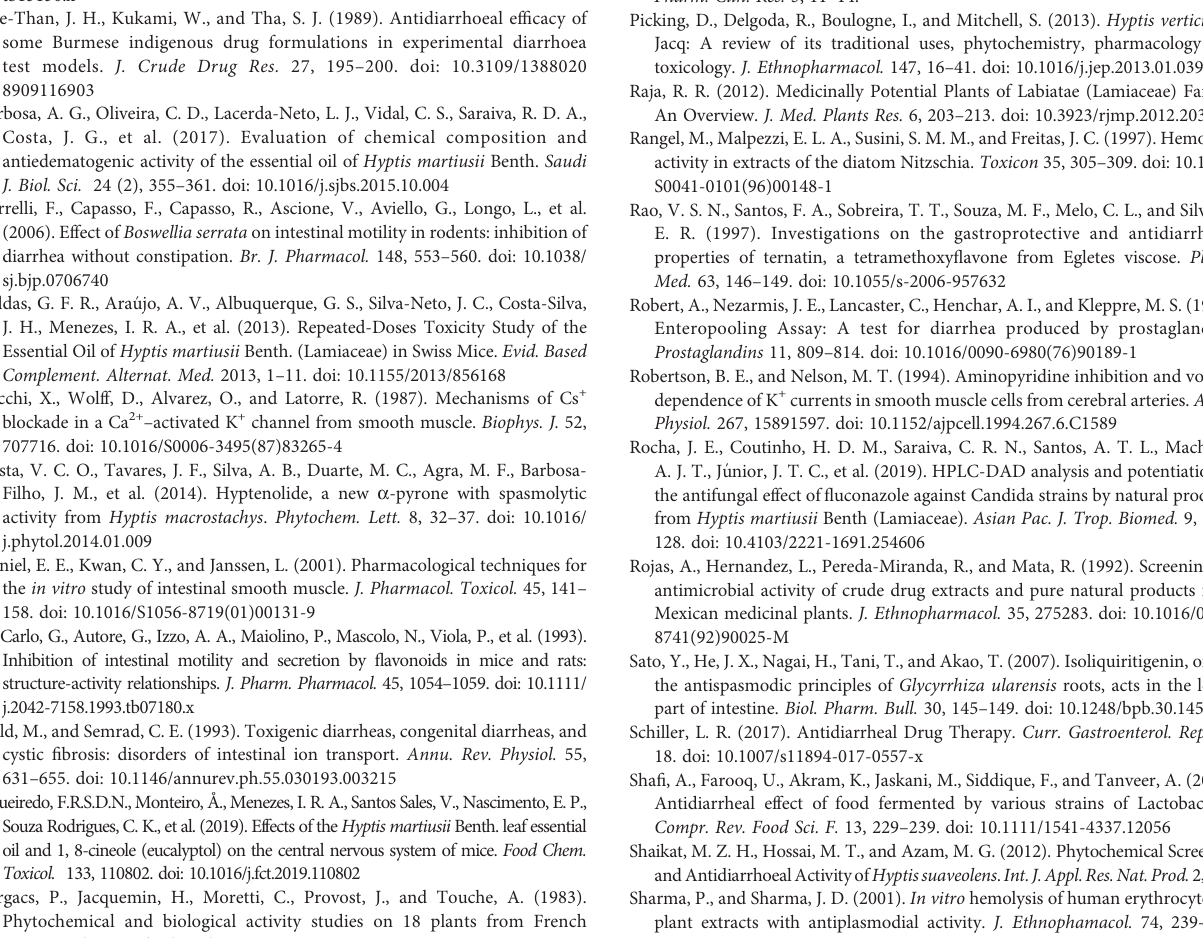
Figueiredo,F.R.S.D.N.,Monteiro,Å.,Menezes,I.R.A.,SantosSales,V.,Nascimento,E.P., SouzaRodrigues,C.K.,etal.(2019).Effectsofthe Hyptismartiusii